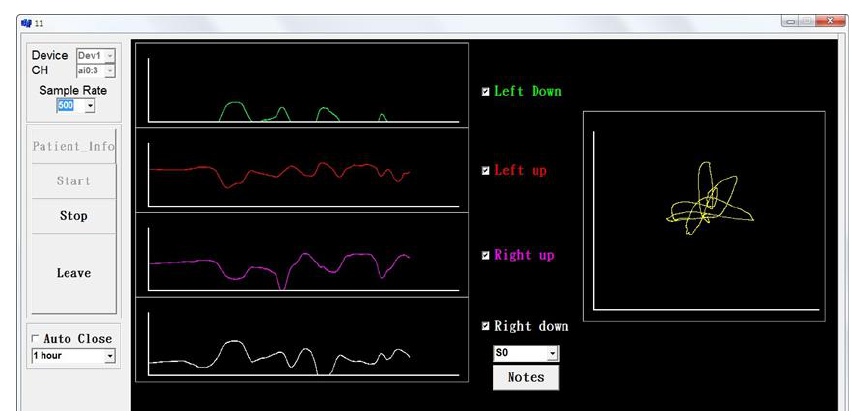
Figure 2. Data receiving